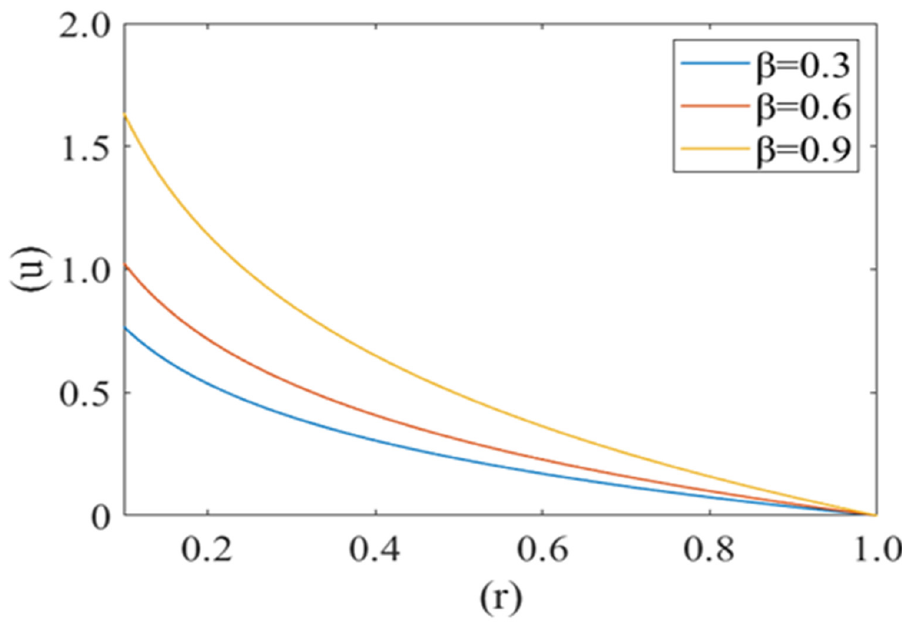
Figure 2. Variation of axial velocity component ( u ) of plasma film with deformed cell radius ( r ) in microcirculation for different value of cell compliance ( β ) with Re = 0.25, P1 = 2, P2 = 2.5. Figure 3 shows the variation in axial fluid velocity of plasma ( u ) for different values of radius of curvature of the deformed shape of cell (i.e., k = 0.1, 0.5, 0.8). It is noticed that fluid velocity is at its maximum at the center of the capillary (i.e., r = 0) and minimum near the capillary wall (i.e., r = 1). No significant variation has been observed for different values of radius curvature of the deformed shape of cell.